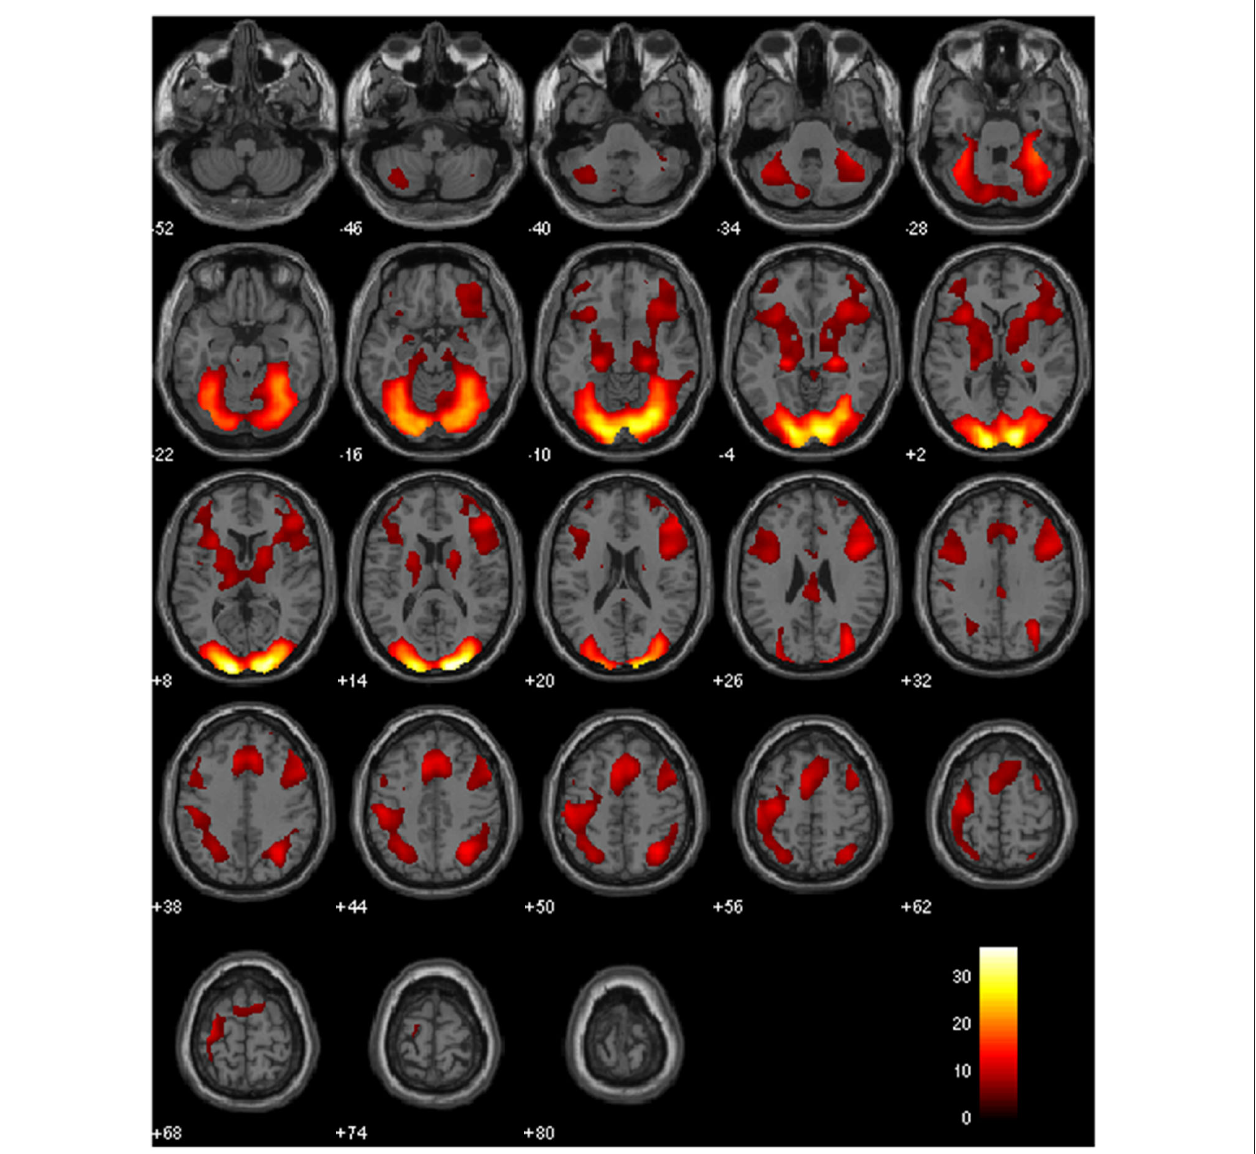
FIGURE 3 | Various regions including bilateral cingulate gyrus and bilateral medial frontal gyrus were activated. The statistical significance refers to p < 0.05 (FWE corrected) at voxel level.